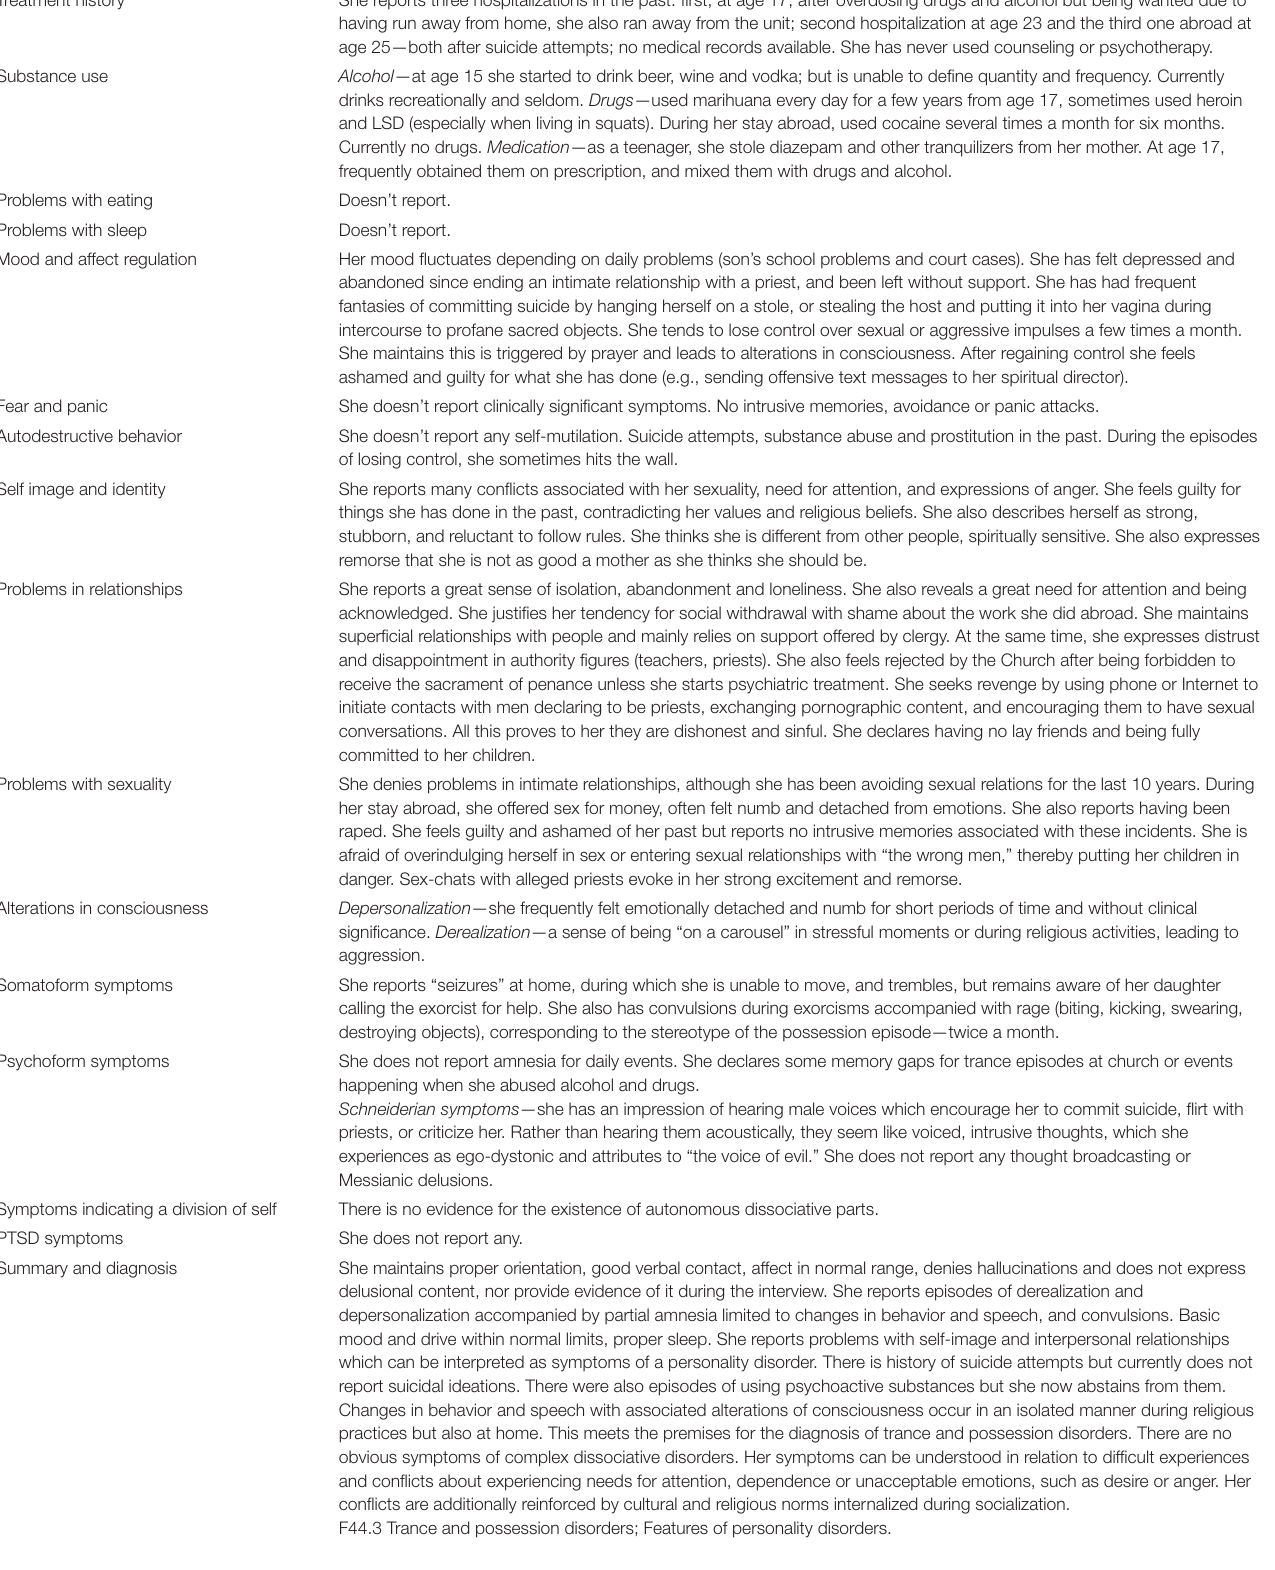
TABLE 3 | The participant’s clinical presentation based on TADS-I profiles . Treatment